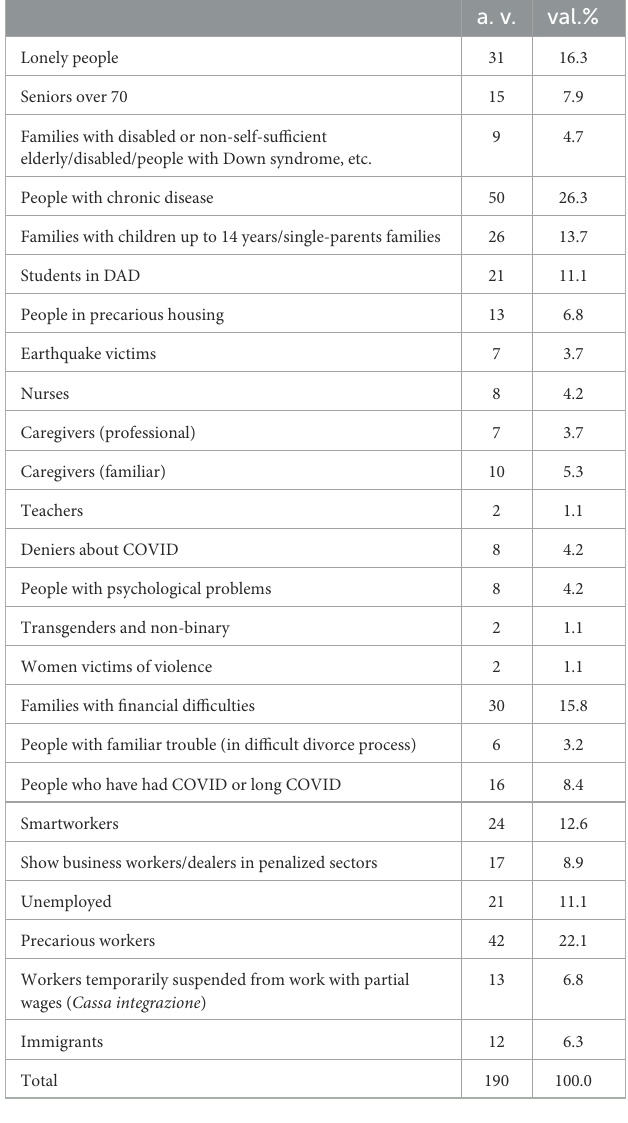
TABLE 1 Respondents by type of initial vulnerability (absolute values and